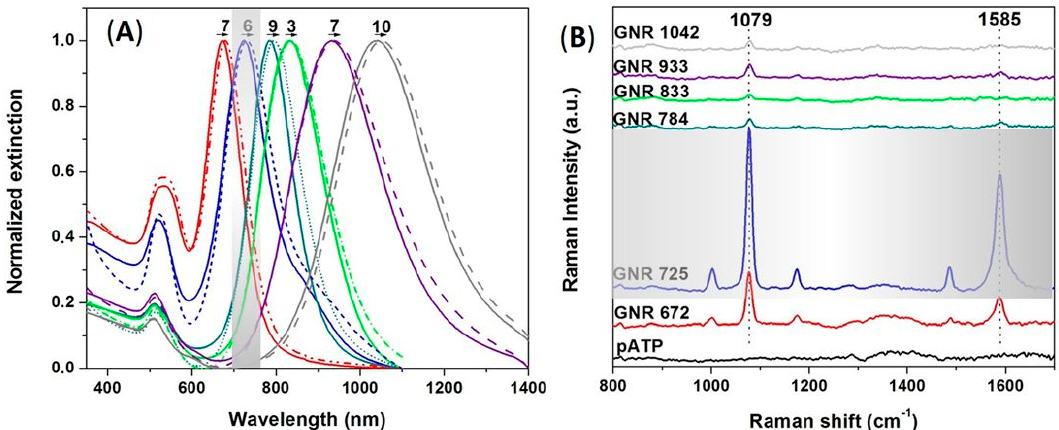
Figure 2. ( A ) Normalized extinction spectra of GNRs before (solid lines) and after (dotted lines) p-ATP grafting; ( B ) surface-enhanced Raman scattering (SERS) spectra of GNRs with different longitudinal localized surface plasmon resonance (LSPR) bands recorded after p-ATP grafting; the black spectrum represents the Raman spectrum of free p-ATP 10 − 4 M solution; Excitation laser line used: 785 nm.